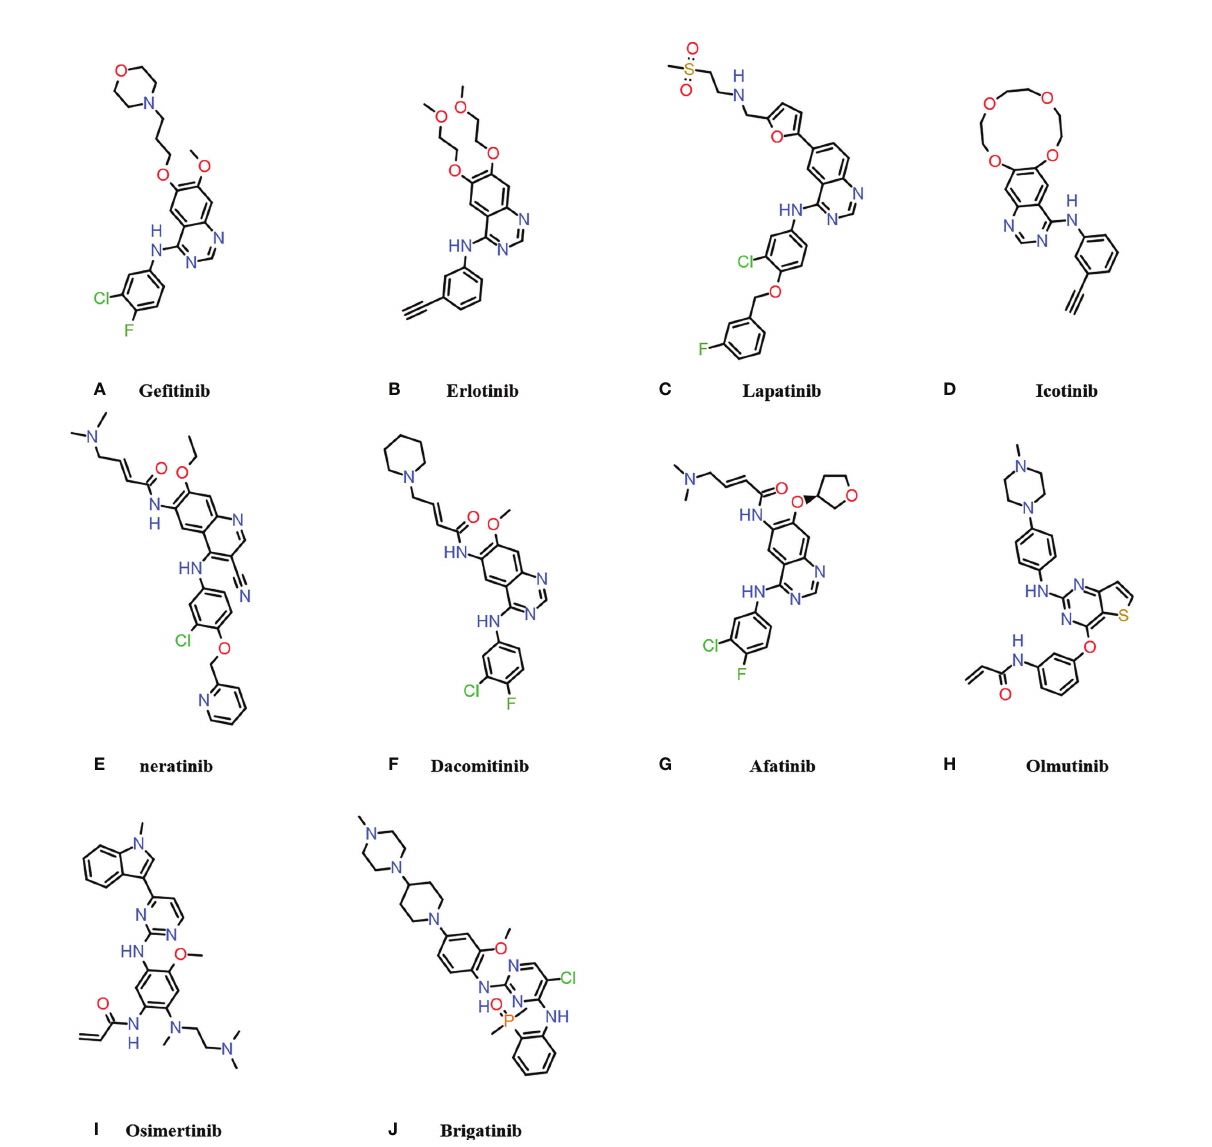
FIGURE 3 | Chemical formula of clinically used EGFR-TKIs. (A – D) are the fi rst generation EGFR-TKIs; (E – G) are the second generation EGFR-TKIs; (H, I) are the third generation EGFR-TKIs; (J) is the fourth generation